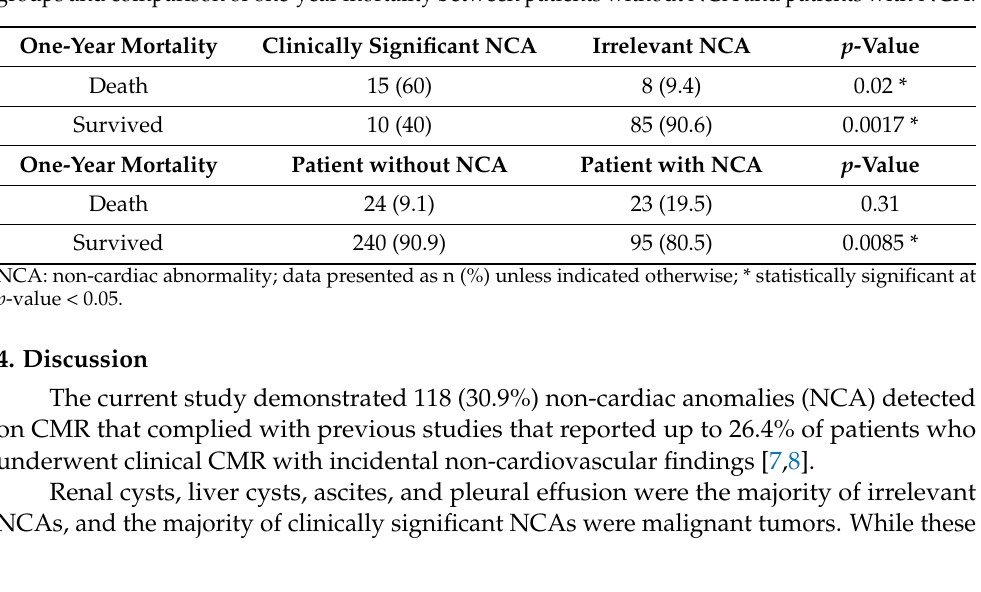
Table 3. Comparison of one-year mortality between clinically significant NCA and irrelevant NCA groups and comparison of one-year mortality between patients without NCA and patients with